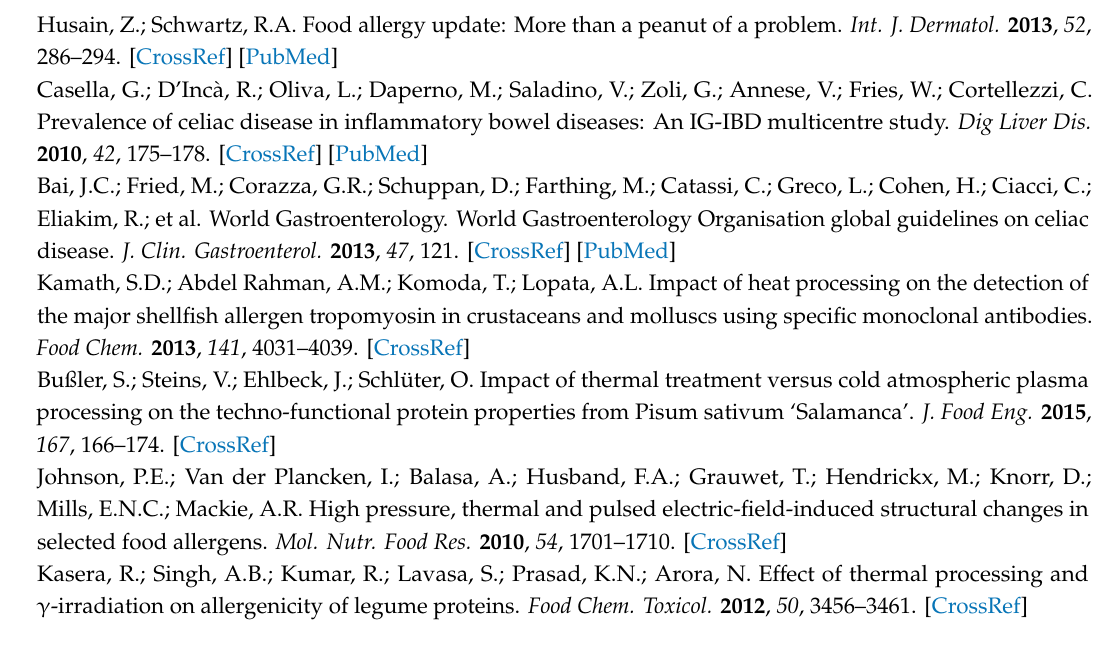
Figure S1: Significance test of protease activity value: * p < 0.05. EPT, extracellular proteinases. IPT, intracellular proteinases, Figure S2: Determination of yeast protease activity. JM1, Torulaspora delbrueckii JM1 . JM2, Pichia anomala JM2 , JM3, Issatchenkia orientalis JM3 . JM4, Saccharomyces cerevisiae JM4 . JM5, Saccharomyces cerevisiaeJM5 , Figure S3: Significance test of peptidase activity value (including PepN, PepI and PepX): * p < 0.05. Pep(I), intracellular peptidase. Pep(E), extracellular peptidase, Figure S4: Gray value analysis by ImageJ Software (A)bands around 15 kDa (B) bands around 25 kDa (C) bands around 40 kDa (D) the total gray value analysis of main bands. Significant di ff erences are determined with * p <